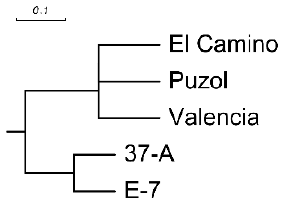
Figure 2. Euclidean distance-based UPGMA phenogram of four pepino varieties (37-A, El Camino, Puzol, and Valencia) and one S. caripense accession (E-7) according to the absence/presence of 24 phenolic compounds detected by HPLC-DAD-MS n /ESI. Table 1. Rt, MS: [M − H] − , MS 2 [M − H] − and relative abundance (%; calculated based on the intensity of the main base peak in the MS 2 fragmentation pattern, which is considered as 100%) of phenolic compounds identified (marked by an X) in fruit samples of pepino ( S. muricatum ) and its wild relative S. caripense samples.